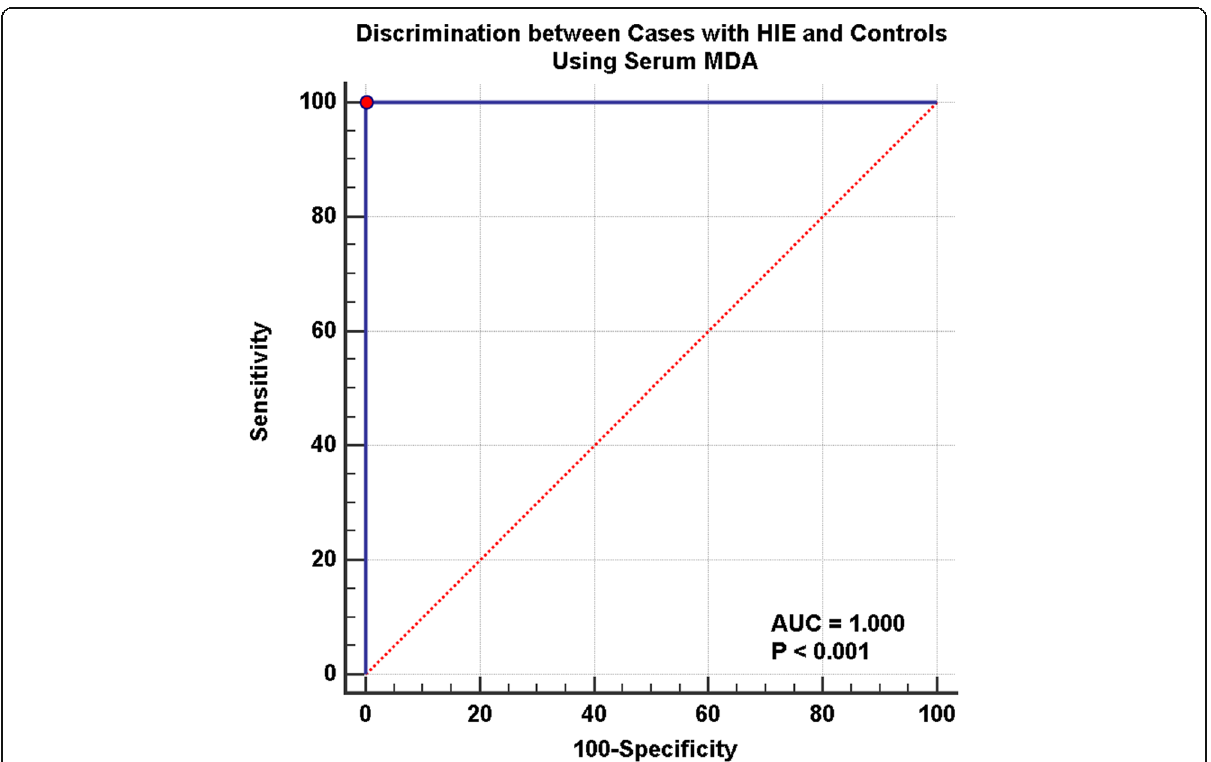
Fig. 2 ROC curve for discrimination between neonates with HIE and controls using serum (MDA) levels